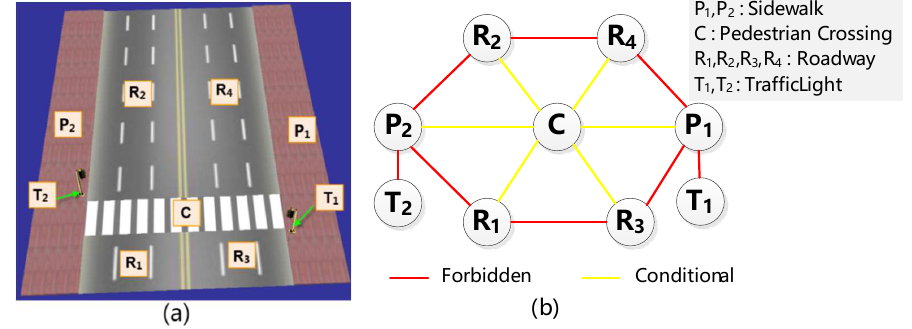
Figure 9. The spatial environment of Case 2: ( a ) the 3D spatial model; ( b ) the grid object network.